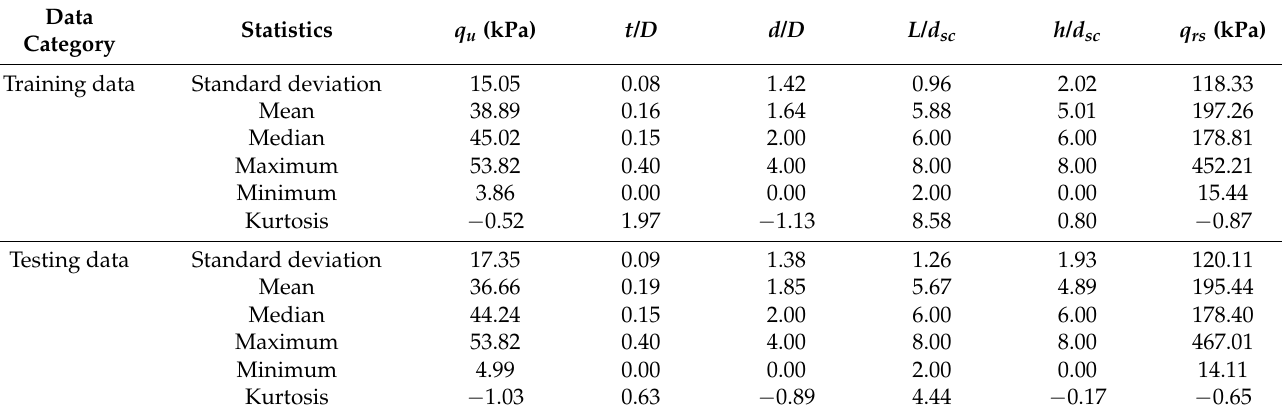
Table 1. Model-variable descriptive